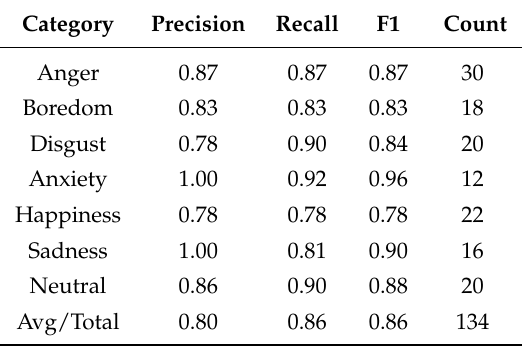
Table 7. Recognition results using proposed method on Emo-DB.